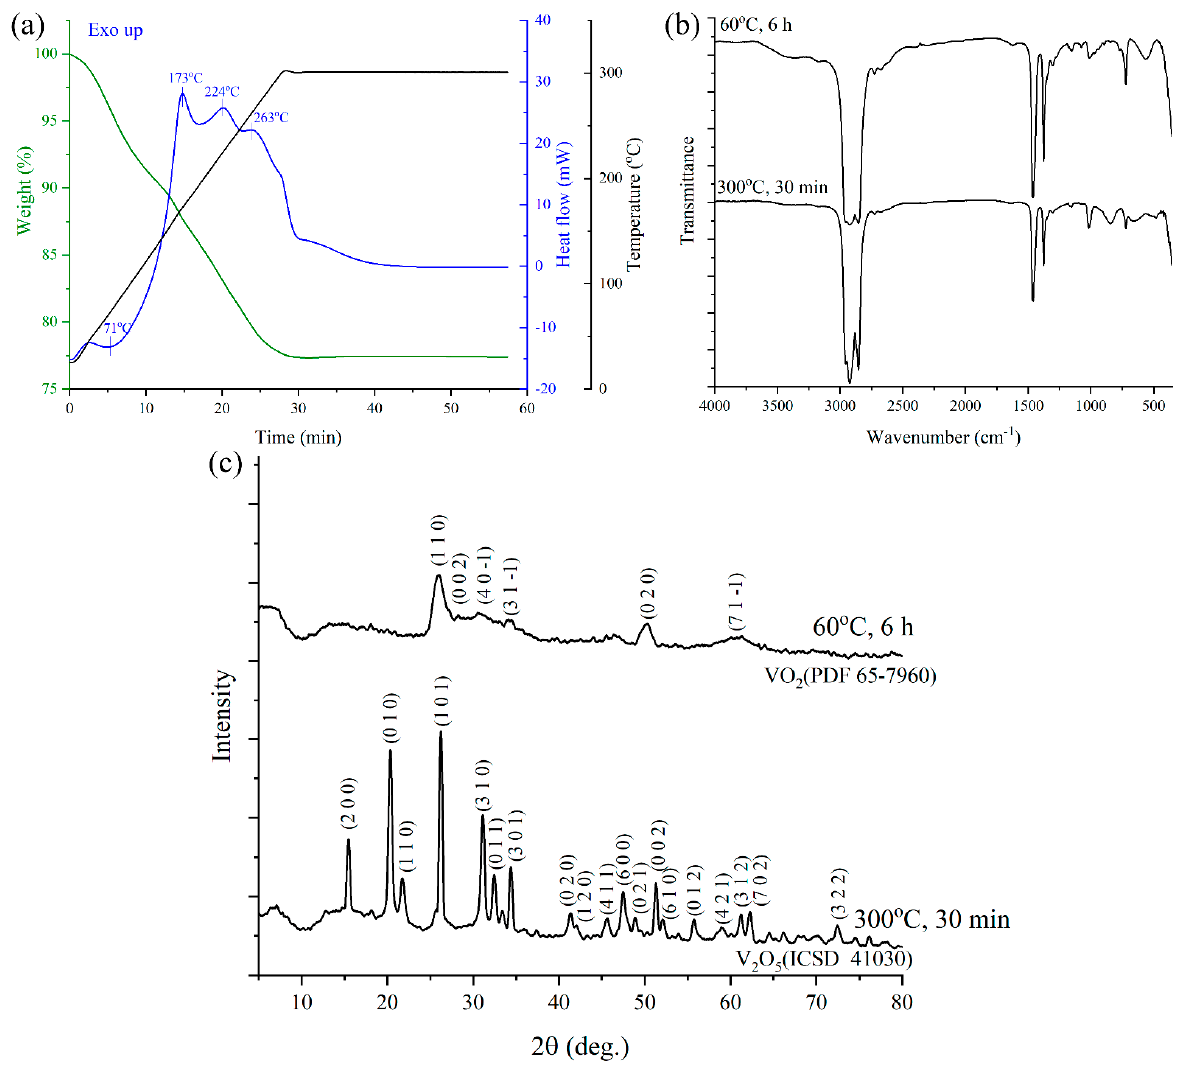
Figure 2. Results of simultaneous thermal analysis for oxide powder after drying: ( a ) IR-spectra for the powder after drying and after annealing at 300 ◦ C; ( b ) Diffractograms for the powder after drying and after annealing at 300 ◦ C ( c ).